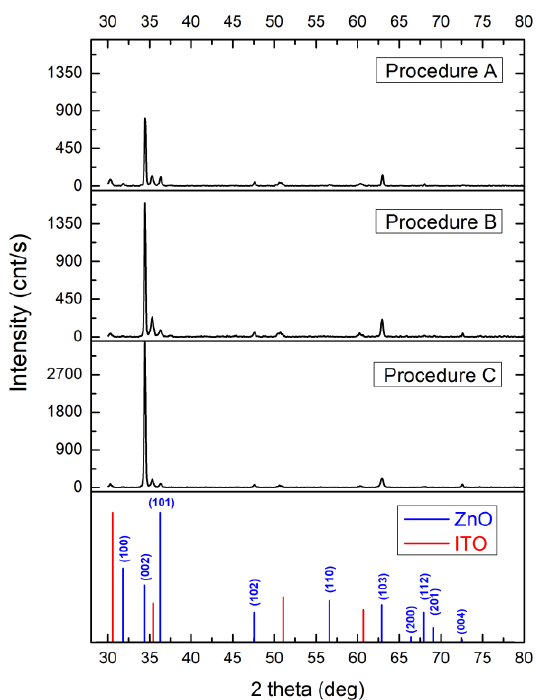
Figure 3. X-ray diffraction spectrum of ZnO nanorods grown in 0.5% formamide for each of the three procedures A, B and C.